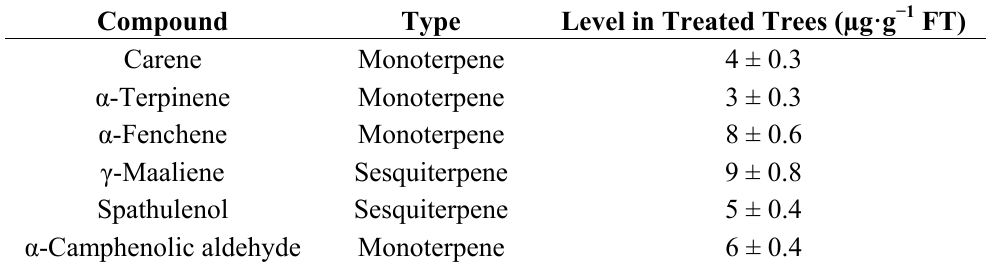
Table 3. Level of de novo synthesized terpenoids in leaves of Eucalyptus trees treated with OC